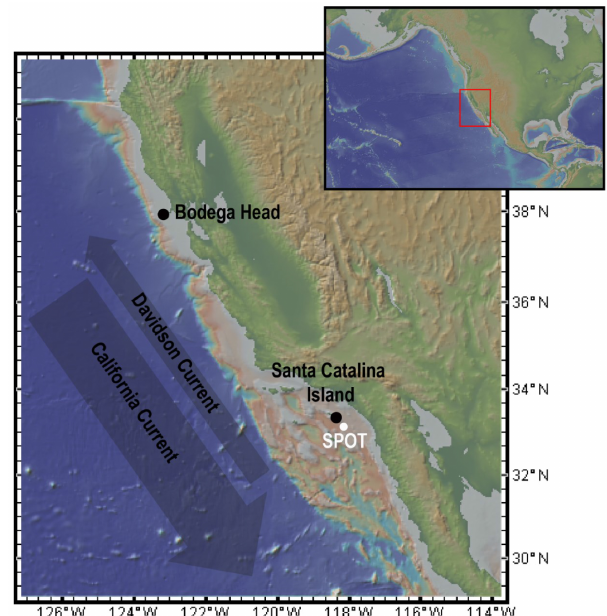
Figure 1. Map of the Californian coast and, at higher magnification, the region within the red box (insert) showing the Bodega Head and Santa Catalina Island sampling locations, (black circles) and the SPOT sampling site (white circle). The hydrography of the region is described in Sect. 2.1, whilst the directions of flow of the two major coastal currents, the California Current and the Davidson Current, are indicated by the